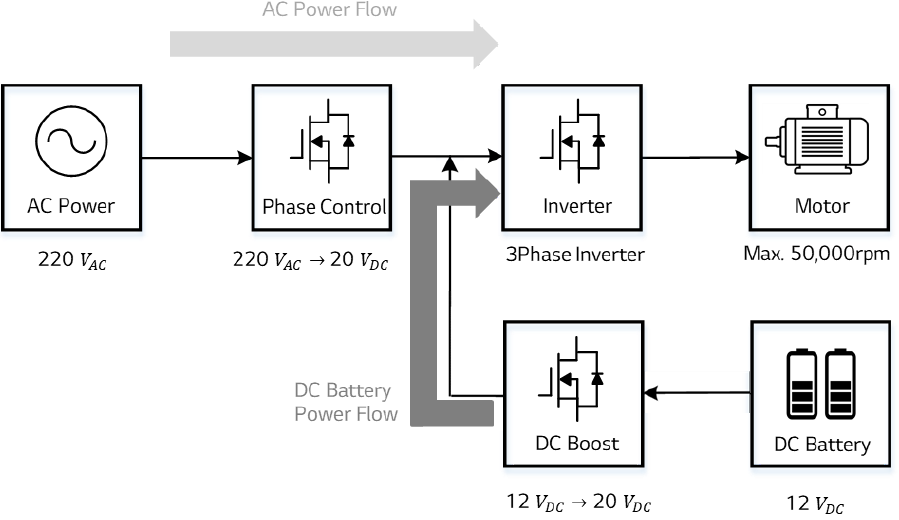
Figure 1. Proposed ultra-high-speed sensorless drive system with two-input power source.